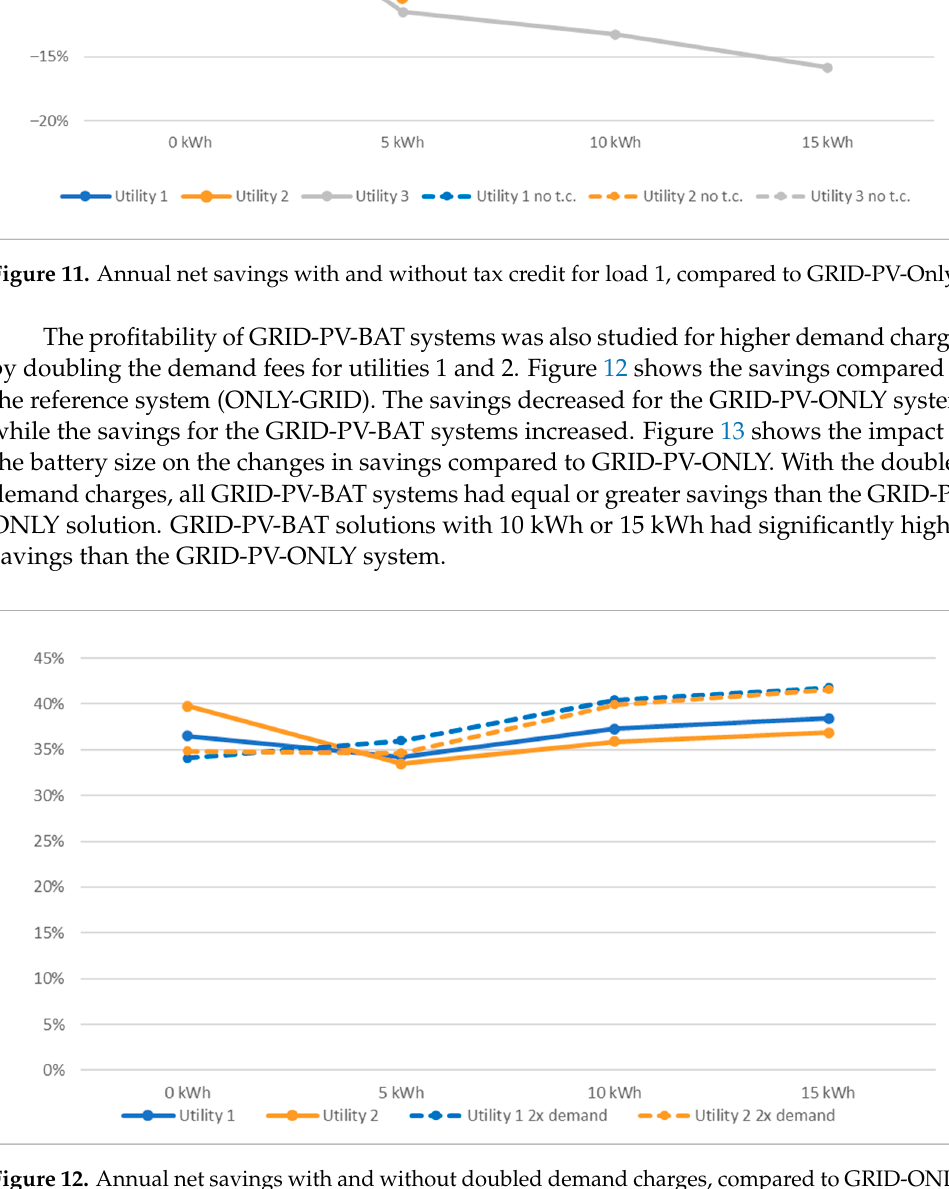
Figure 12. Annual net savings with and without doubled demand charges, compared to GRID- ONLY.